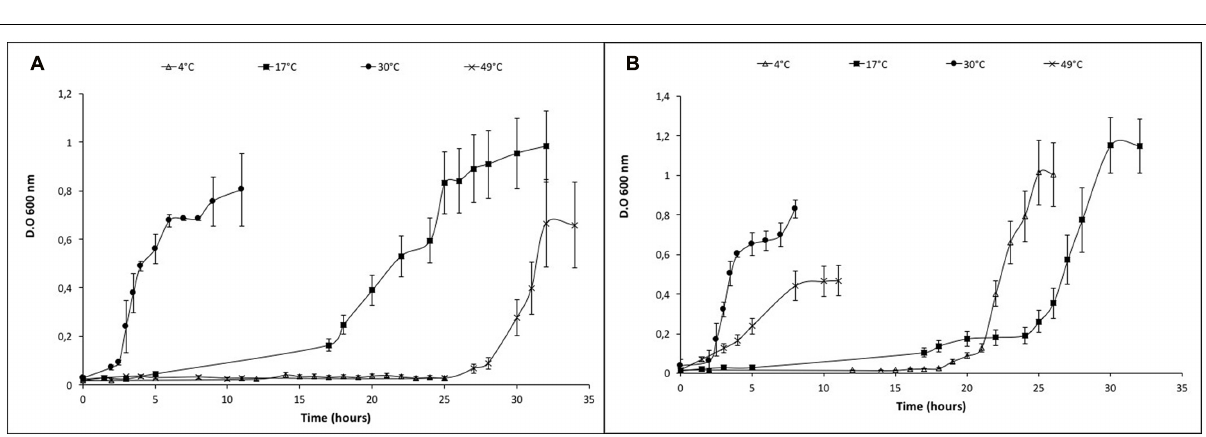
FIGURE 2 | Growth curves of Vibrio sp. at different temperatures in presence and absence of NaCl. (A) Vibrio sp. cells grown in absence of salt (0 g/L NaCl) (B) Vibrio sp. cells grown in presence of salt (25 g/L NaCl). The temperature was changed from 4 ◦ to 49 ◦ C under both growth